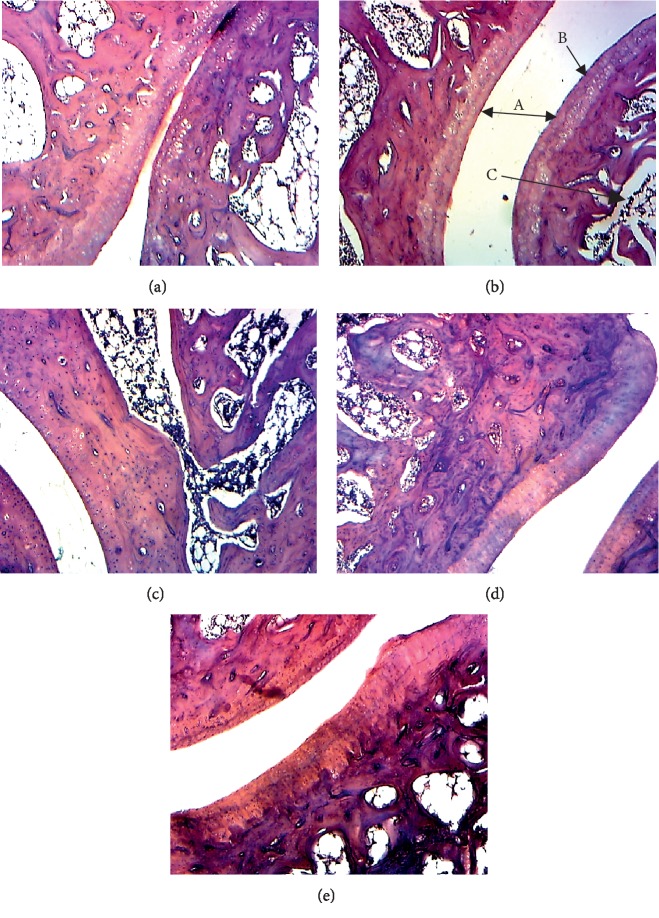
Histopathological analysis of ankle joints stained with H&E. (a) Healthy control showing normal structure with small joint space; (b) arthritic control showing very large joint space (A), destruction of cartilage (B), bone erosion (C), and cellular infiltration (D); (c) diclofenac 5 mg/kg treated, (d) aqueous extract (AE) 250 mg/kg treated, and (e) ethanolic extract (EE) 250 mg/kg treated showing a decrease in joint space, a reduction of cells infiltration and reduction of cartilage destruction.